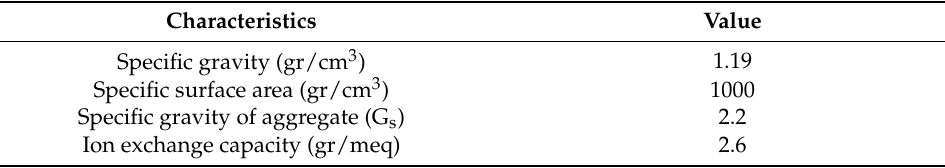
Table 2. Physical and chemical properties of the zeolite. Table 3. Chemical analysis of zeolite.